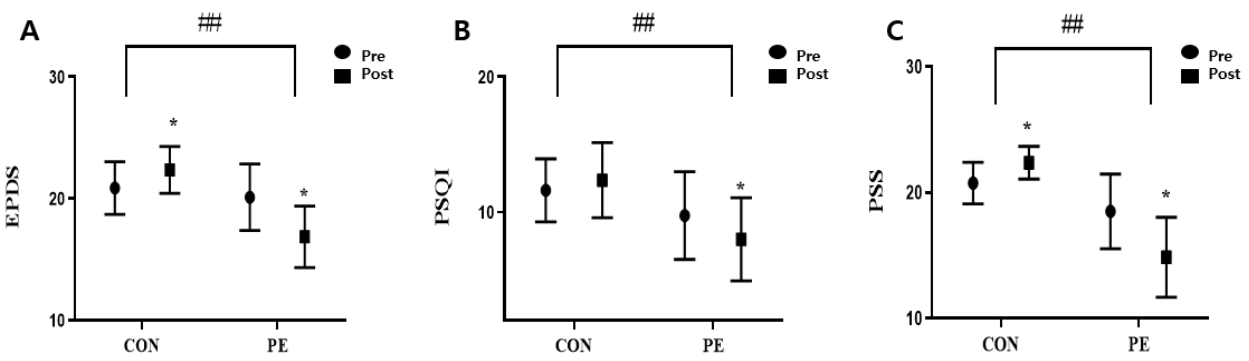
Table 5. Psychological effects.